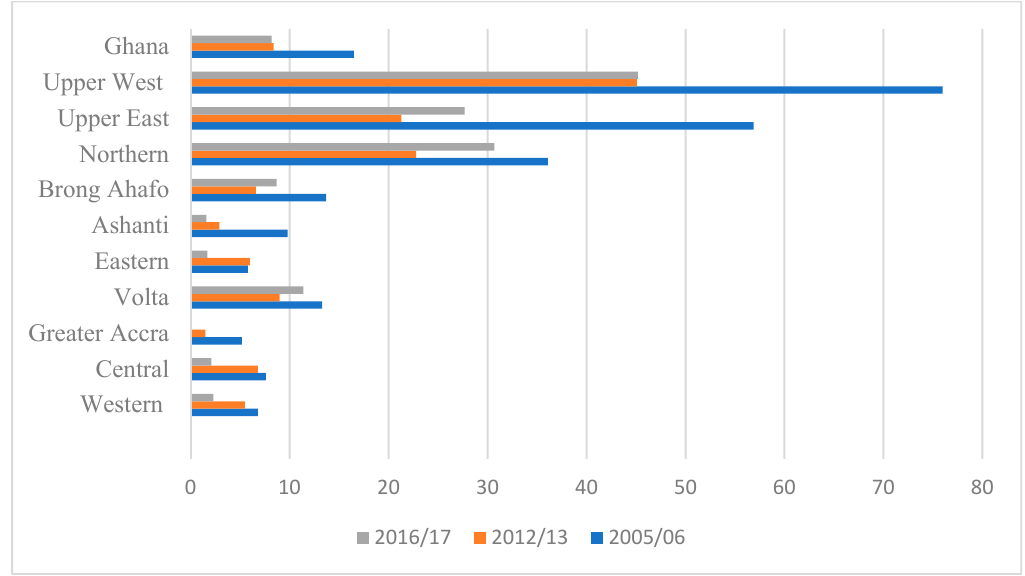
Figure 1. Extreme Poverty incidence (PO) by region. Source: Ghana Statistical Service (2018).